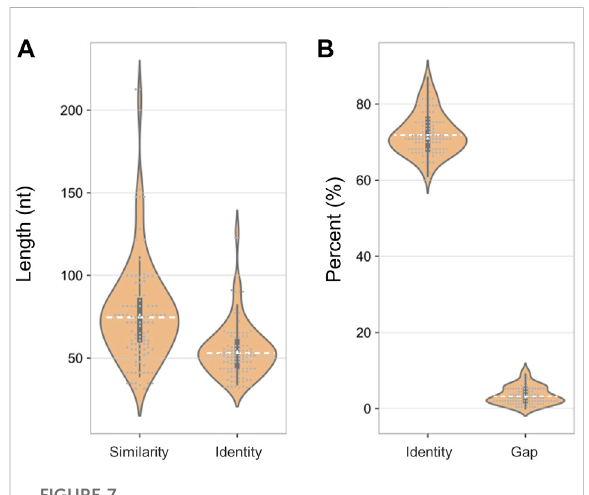
Sequence characteristics of similar loci between the SARS- CoV-2 genome and human transcriptome. (A) Length of similar and consensus sequences. (B) The proportion of identity and